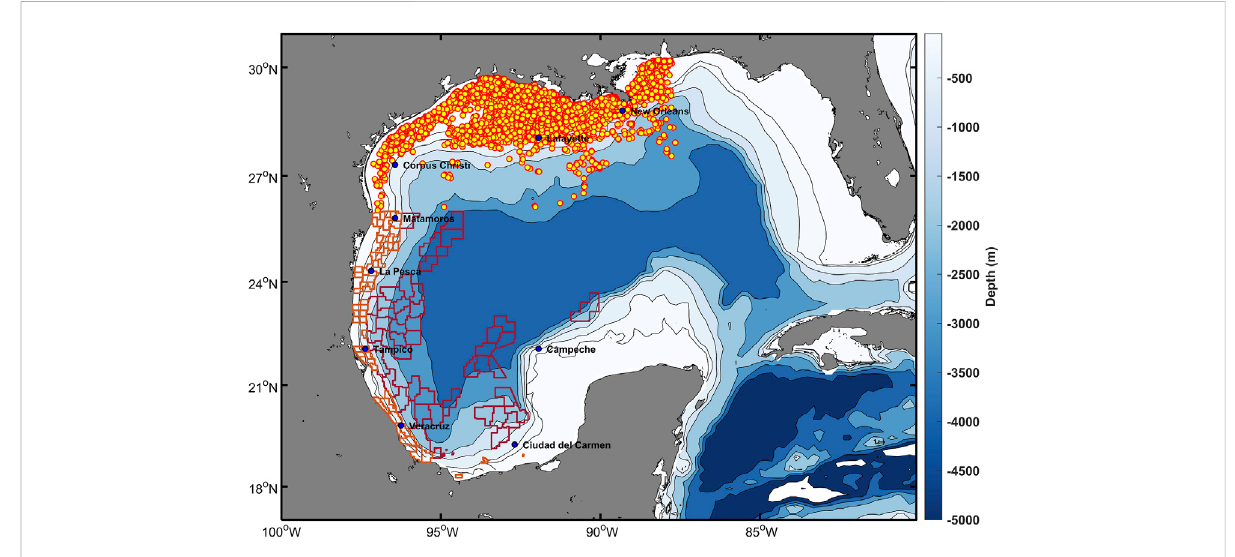
FIGURE 1 Studyarea,showingUSoffshoreoilplatforms(yellowdots)andoilexploitationareasintheGoM(ComisiónNacionaldeHidrocarburos,CNH)in both shallow and deep water (orange and red respectively), and virtual sites (blue